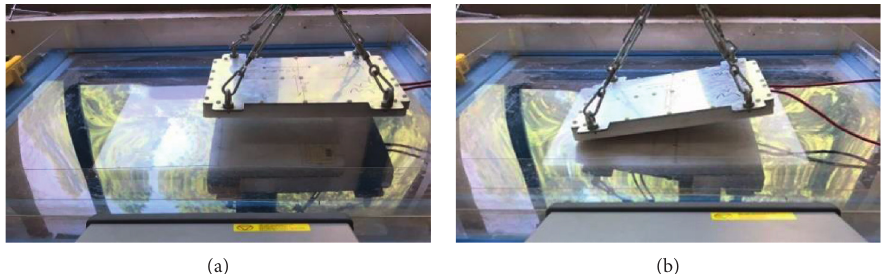
Figure 13: Coil setting in mutual inductance model verification experiment. (a) Migration experiment. (b) Tilt